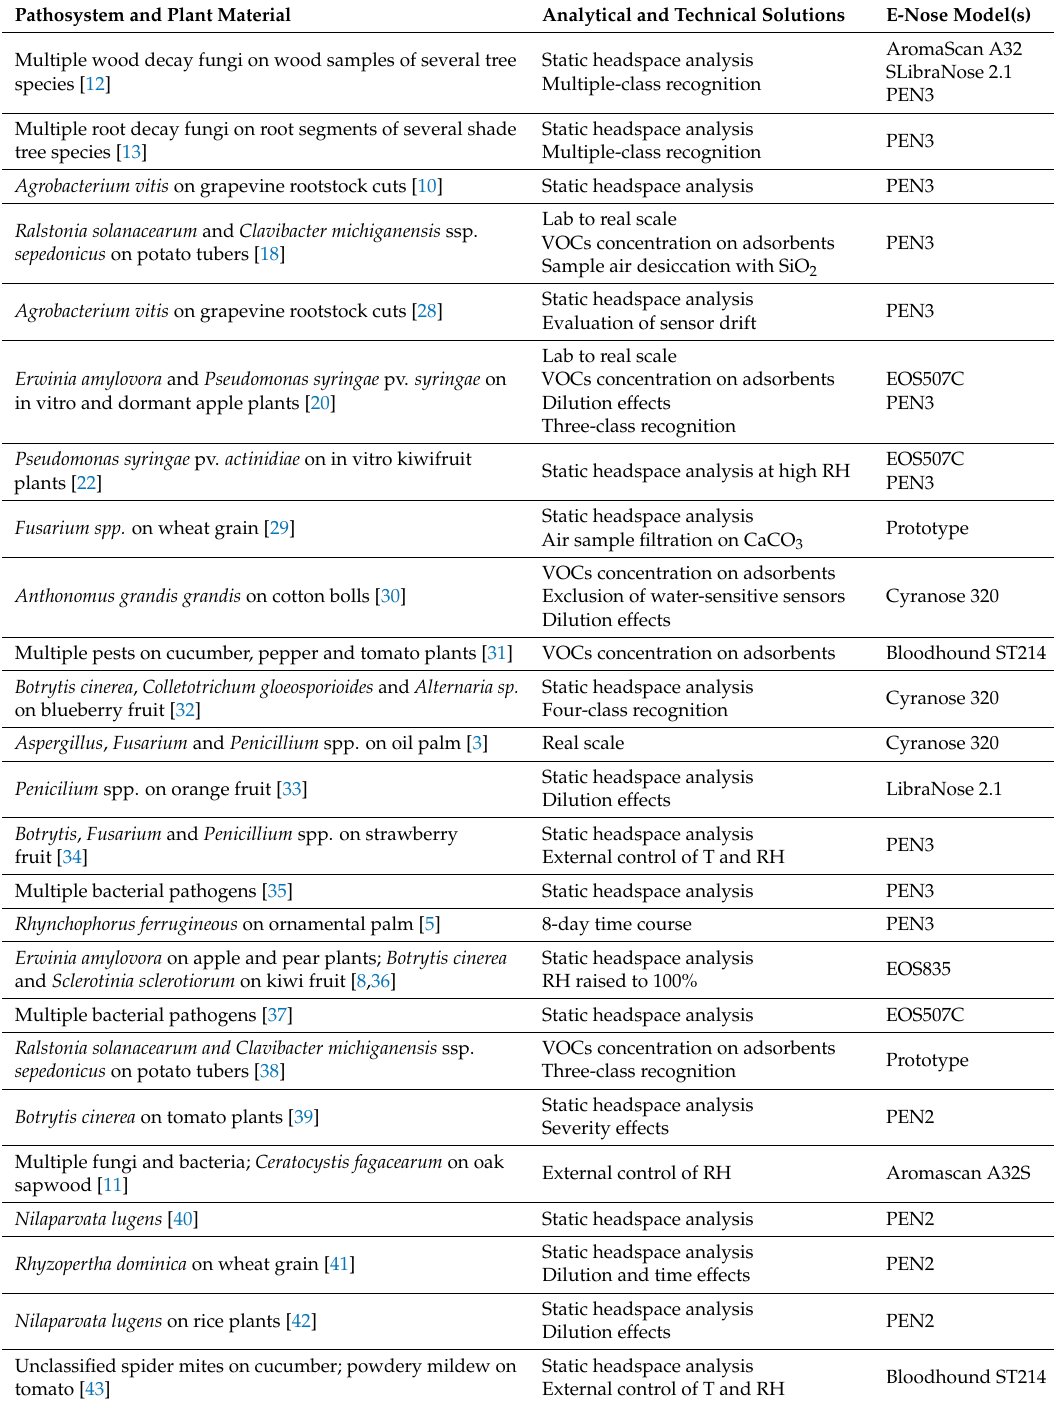
Table 1. Applications of e-nose to plant disease and pest diagnosis. Pathosystems, analytical details and e-nose model are